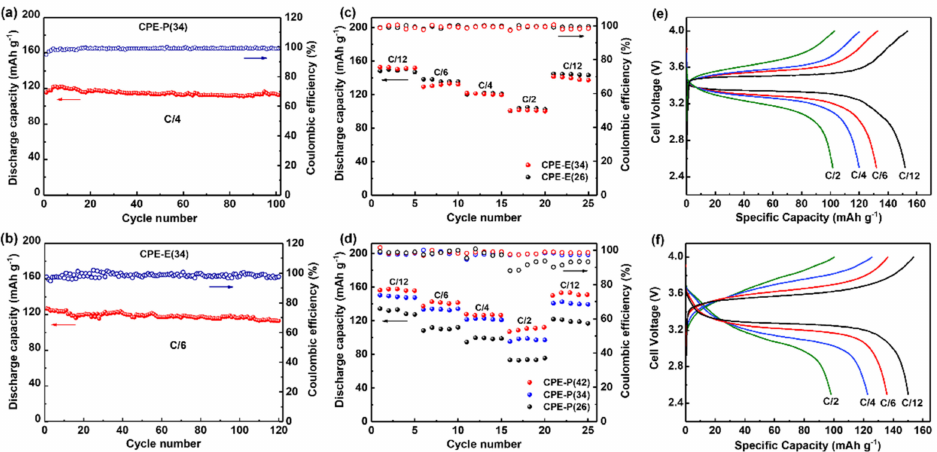
Figure 8. Cycling stability and coulombic efficiency of Li/LiFePO 4 cells with CPE-P(34) at a C/4 rate ( a ) and CPE-E(34) at a C/6 rate ( b ) at 20 ◦ C. Rate performance and corresponding coulombic efficiency of Li/LiFePO 4 cells with CPE-E ( c ) and CPE-P ( d ) at 20 ◦ C. Voltage profiles for the cells of Li|CPE-E(34)|LiFePO 4 ( e ) and Li|CPE-P(34)|LiFePO 4 ( f ) at different current rates at 20 ◦